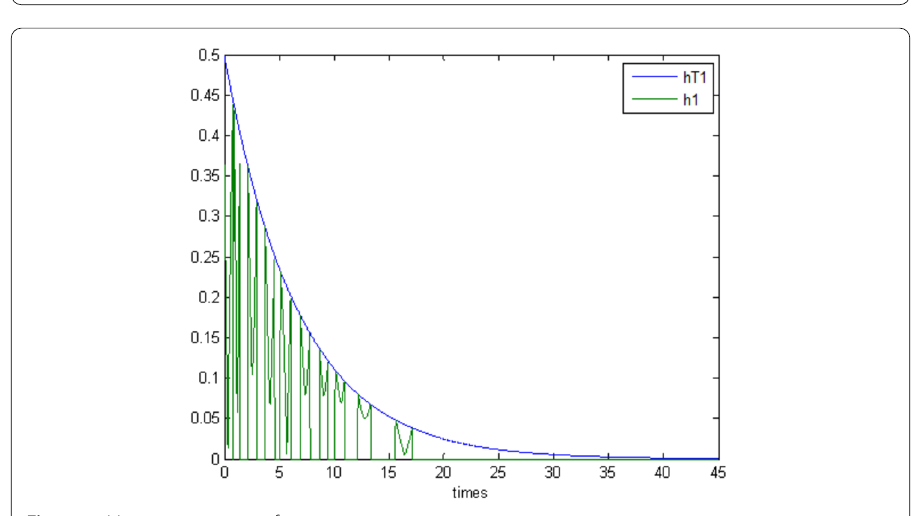
Figure 5 Measurement error of agent x 1